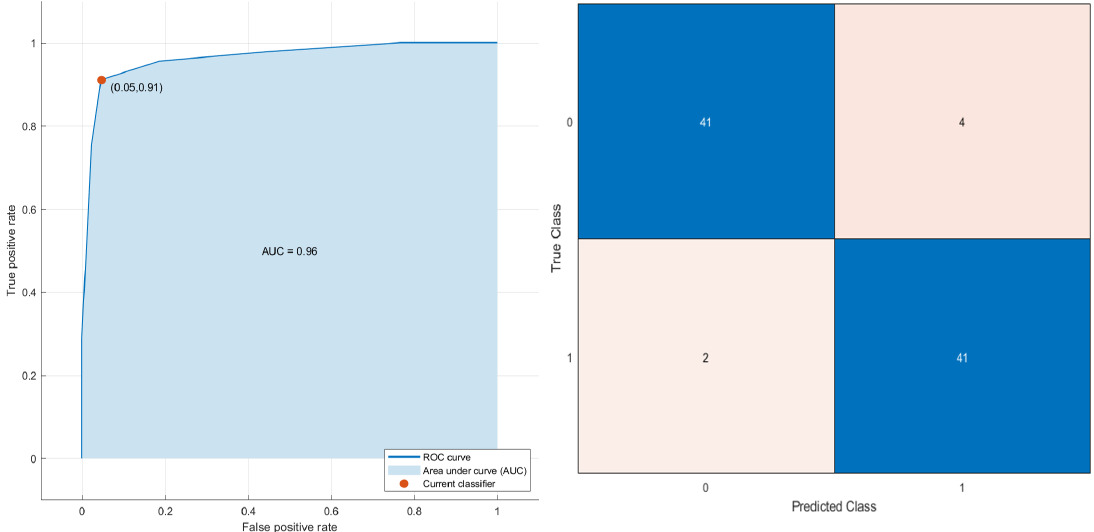
Figure 6. ROC curve and confusion matrix of decision tree as the best classifier for stratifying the patients based on PFS time (short and time).